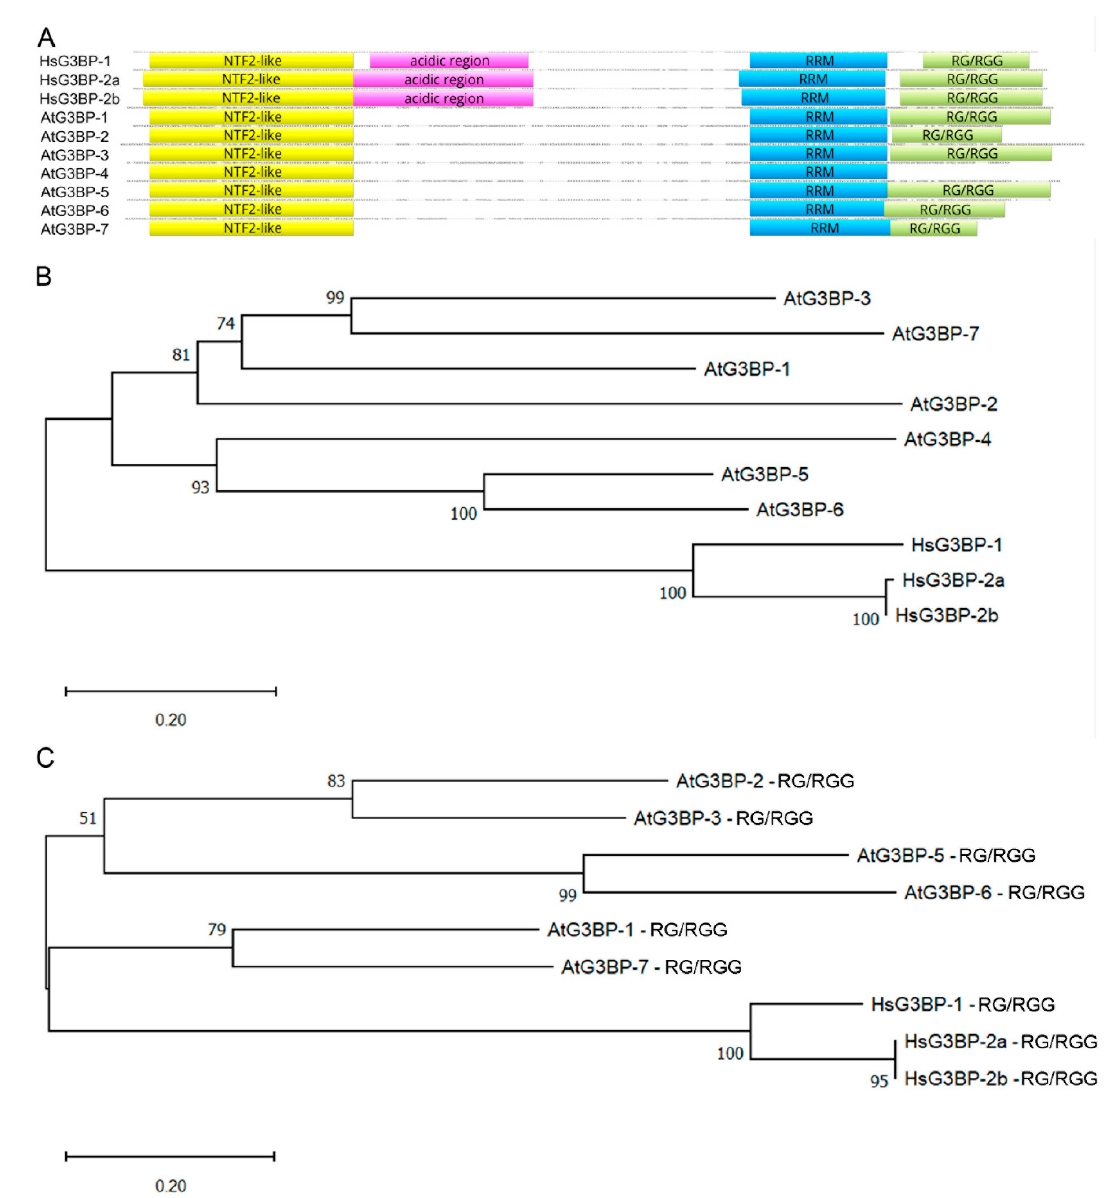
Figure 1. ( A ) Schematic alignment of the HsG3BPs with the G3BPs from A. thaliana generated with Geneious Prime ® 2020 software. NTF2-like domain, acidic region, RRM and RG/RGG domains are annotated and highlighted with yellow, purple, blue and green boxes, respectively. Domains, regions and motifs were identified using ProSITE [24]. ( B ) Phylogenetic tree of the full-length proteins and ( C ) the RG/RGG domains of the Arabidopsis G3BP-family and HsG3BP-1, -2a and -2b. The evolutionary history was inferred using the neighbor-joining method [23]. The optimal tree with the sum of branch length = 4.77 ( B ) and 3.58 ( C ) is shown. The percentage of replicate trees in which the associated taxa clustered together in the bootstrap test (1000 replicates) are shown next to the branches [25]. The trees are drawn to scale, with branch lengths in the same units as those of the evolutionary distances used to infer the phylogenetic tree. The evolutionary distances were computed using the Poisson correction method [26] and are in the units of the number of amino acid substitutions per site. This analysis involved 9 amino acid sequences. All ambiguous positions were removed for each sequence pair (pairwise deletion option). There were a total of 98 positions in the final dataset. Evolutionary analyses were conducted in MEGA X [27].